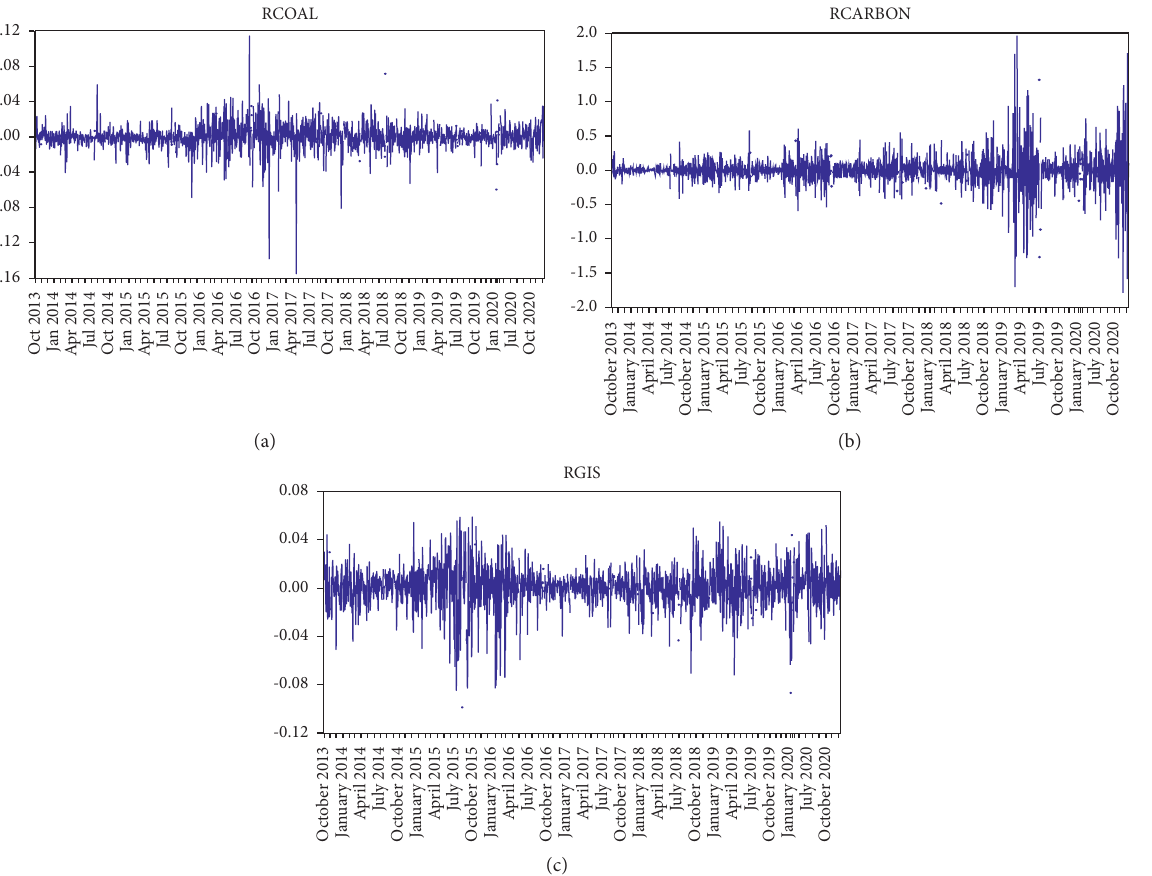
Figure 2: Returns of carbon, coal, and green investing market. (a) RCOAL. (b) RCARBON. (c) RGIS. Table 4: Coefficients of unconditional correlations. RCARBON RCOAL RGIS